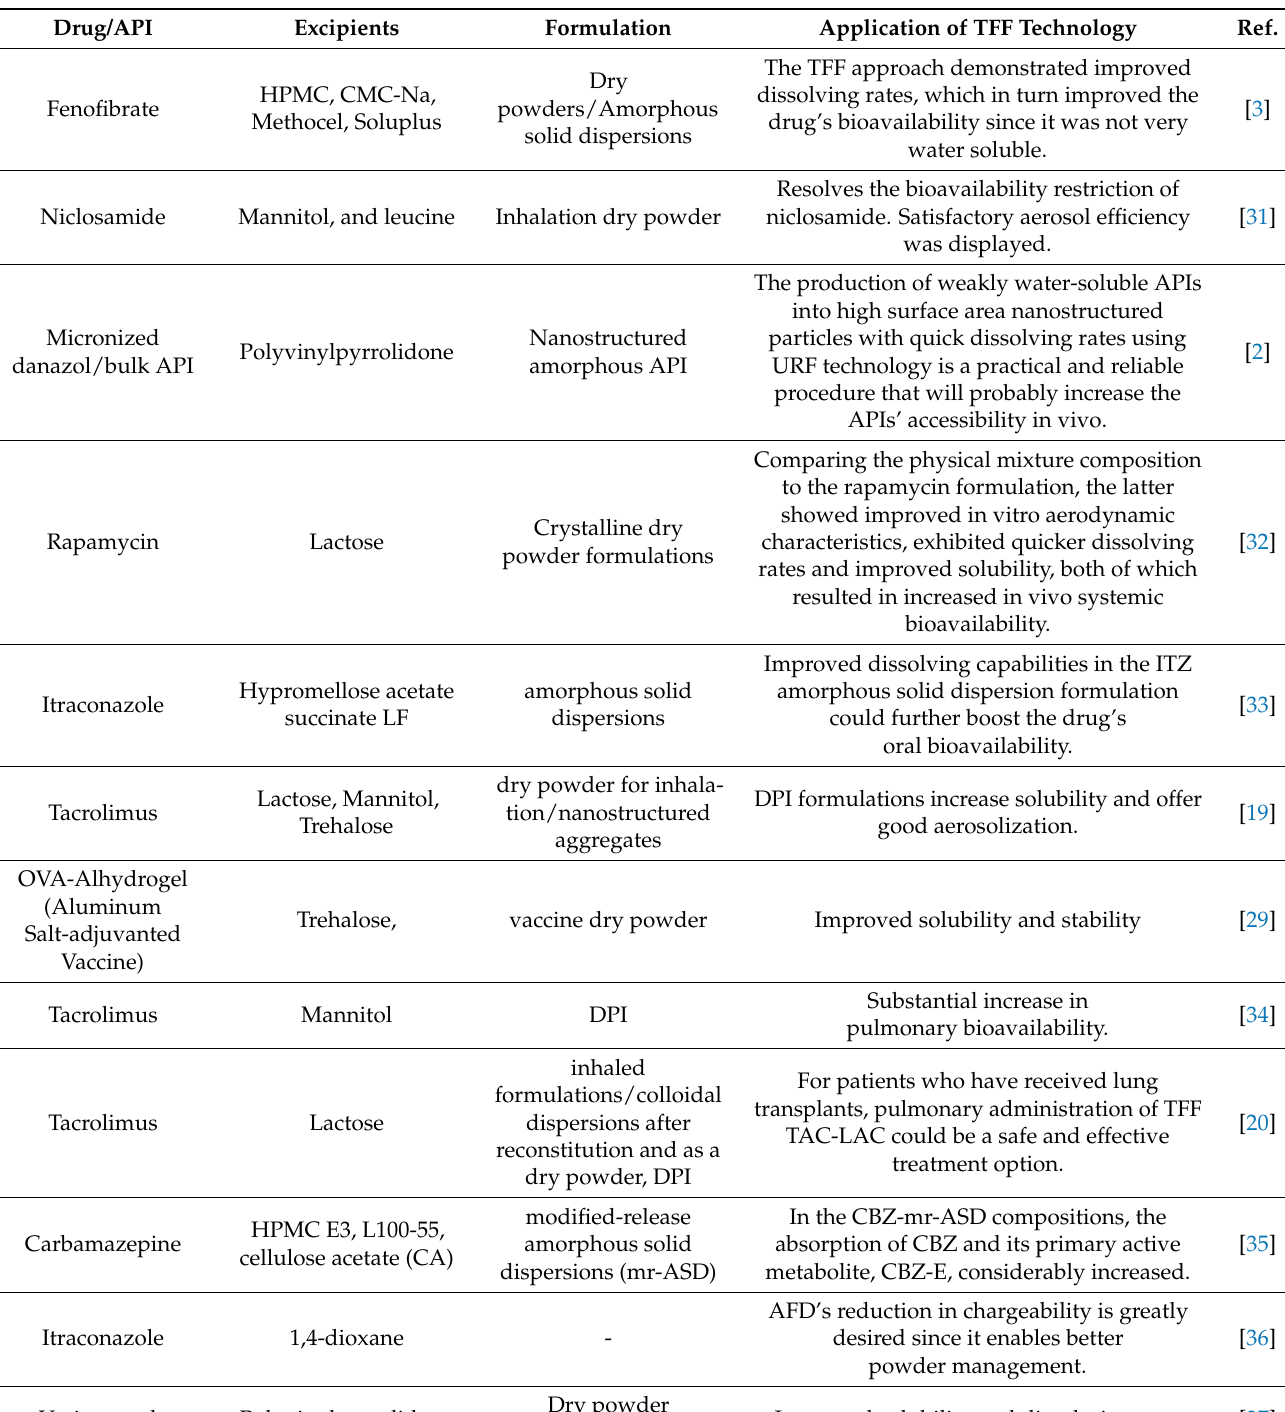
Table 2. TFF Technology for low solubility